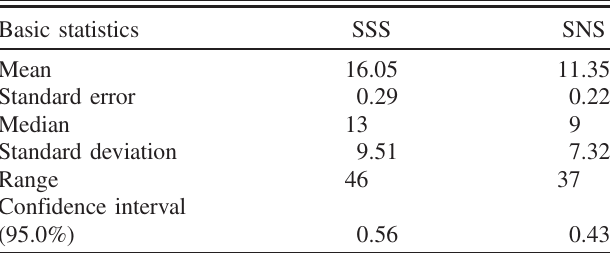
TABLE I. Basic statistics for two scoring systems: simple sum score and single number score.